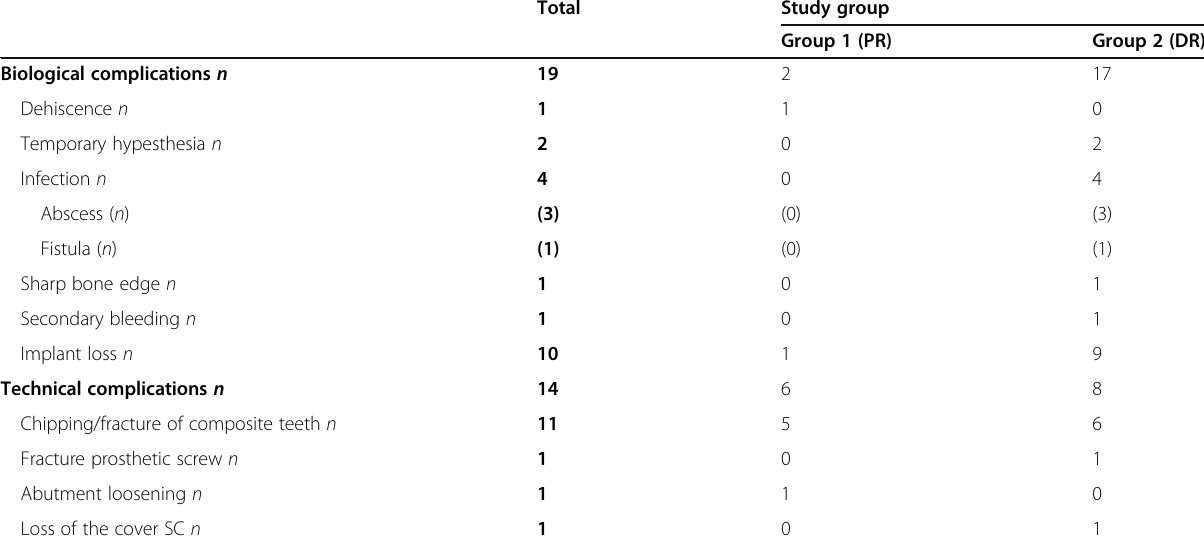
Table 2 Individual biological and technical complications per group within the healing period of 3 months Total Study group